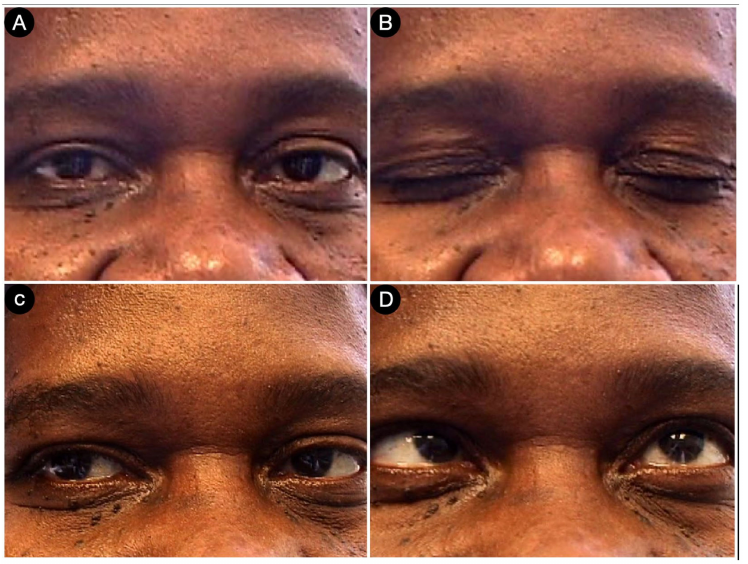
Figure 22. ( A – D ) Postoperative pictures of the patients, showing the abducens nerve palsy.